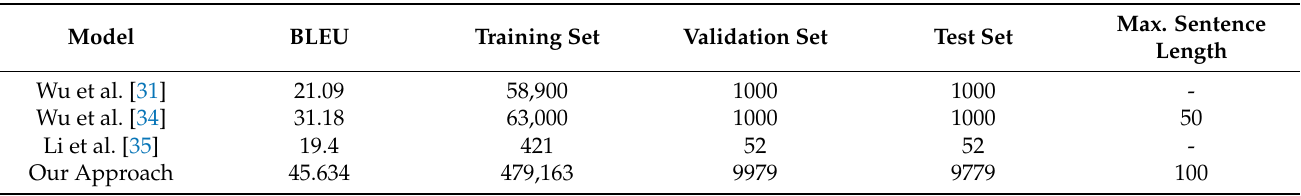
Table 8. Performance of different Traditional Mongolian-Chinese machine translation approaches on various